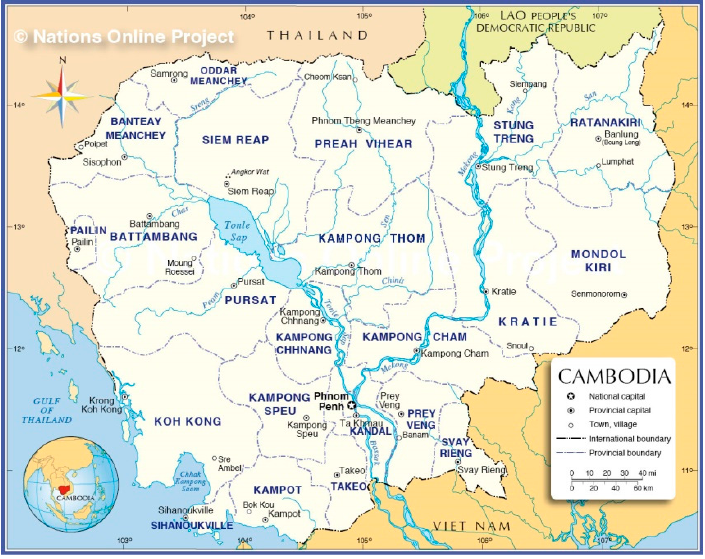
Figure 1. Map of Figure 1. Map of Cambodia